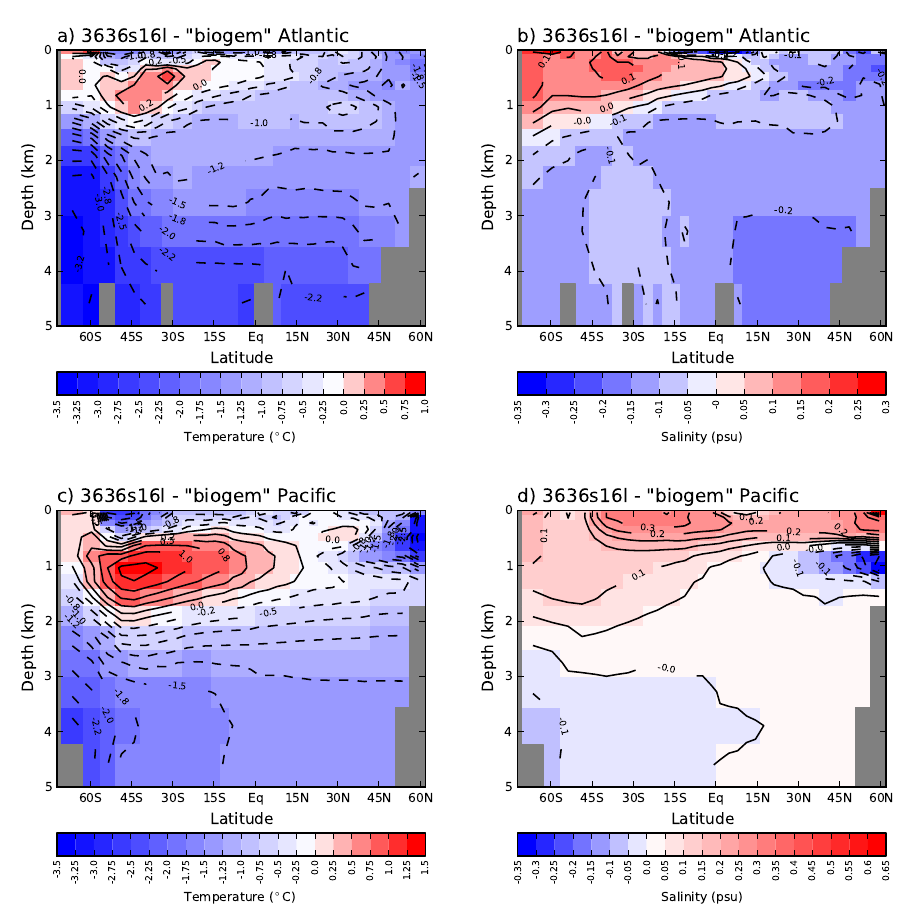
Fig. 12. “3636s16l” minus “biogem” differences for the property sections in Fig.